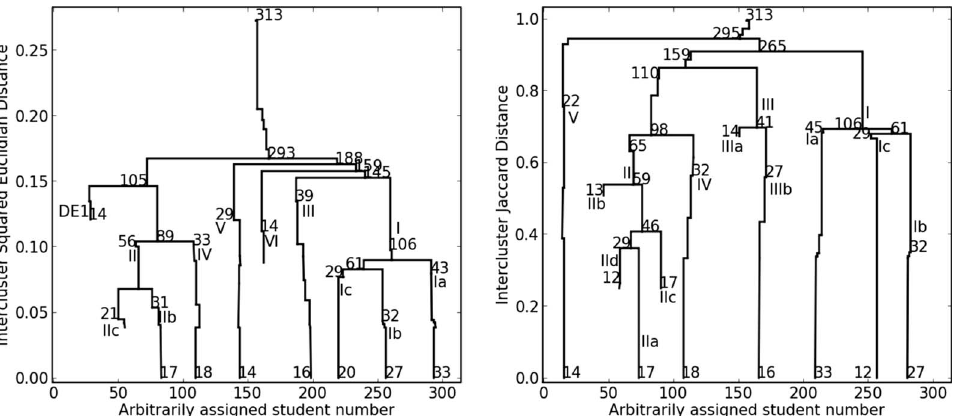
FIG. 1. The graph on the right shows the results of the cluster analysis with the square Euclidian distance (cid:1) i.e., a reproduction of Fig. 4 from the original paper, except with the new group, subgroup, and deadend numbering applied (cid:2) , while the one on the left shows the results of the cluster analysis with the Jaccard distance. Note that a student’s position along the x-axis is not necessarily consistent between the two